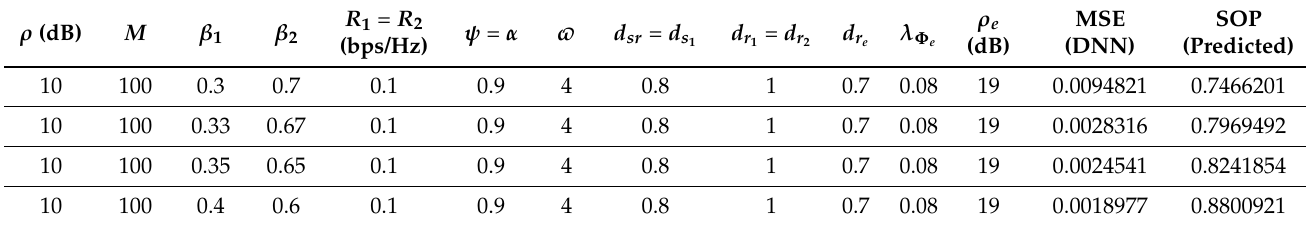
Table 2. The parameters of the proposed method for better